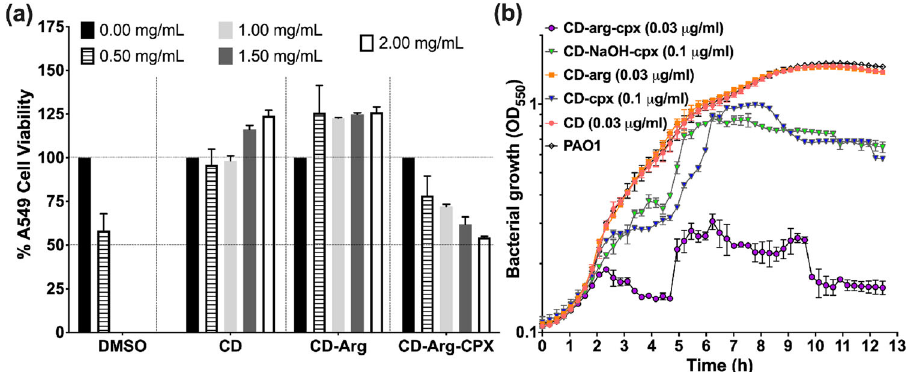
Fig. 6 Antimicrobial properties vs. cytotoxicity of CD complexes. Cytotoxicity of β CD-arg-cpx and its components to lung epithelial A549 cells ( a ). The plot shows the percentage of A549 cell viability after incubation with different concentrations of β CD complexes (0 mg/ml (black), 0.5 mg/ml (patterned), 1 mg/ml (light grey), 1.5 mg/ml (dark grey) and 2 mg/ml (black border). DMSO was used as a positive control for toxicity, while untreated A549 monolayers were used as a negative control for cytotoxicity; n = 3; error bars refer to SD of viability relative to non-treated cells. Comparison of P. aeruginosa PAO1 growth (white) in the presence of β CD-arg-cpx (0.03 μ g/ml or 0.020 μ M) (purple), β CD-NaOH-cpx (0.2 μ g/ml or 0.132 μ M) (green), β CD-cpx (0.2 μ g/ml or 0.140 μ M) (blue), β CD-arg (0.03 μ g/ml or 0.0023 μ M) (orange) and β CD (0.03 μ g/ml or 0.0026 μ M) (rose) ( b ); n = 3; error bars refer to optical density